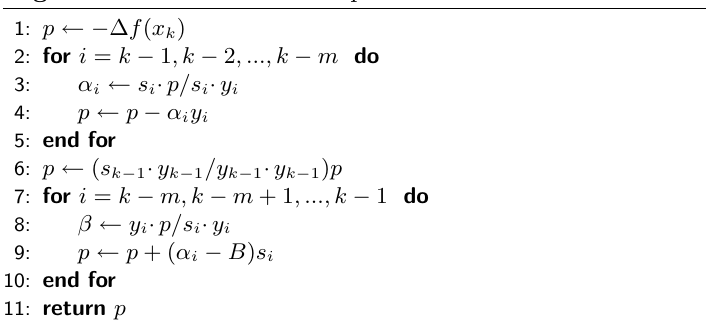
Algorithm 2 L-BFGS two-loop